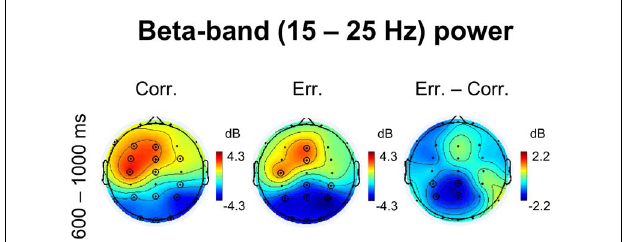
FIGURE 4 | Non-phase locked beta-band power. Topographical maps of baseline-corrected beta-band activity at 600 – 1000 ms relative to response (left map represents correct responses, middle map – errors, and right map – difference: errors minus correct responses). Significant electrodes are highlighted with black circles ( p < 0.05, TFCE, permutation